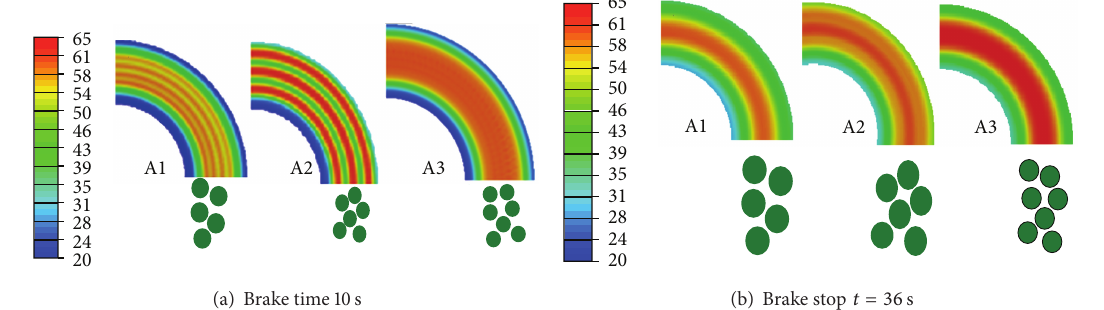
Figure 4: Distribution of brake disc surface temperatures of different structures of brake pads.